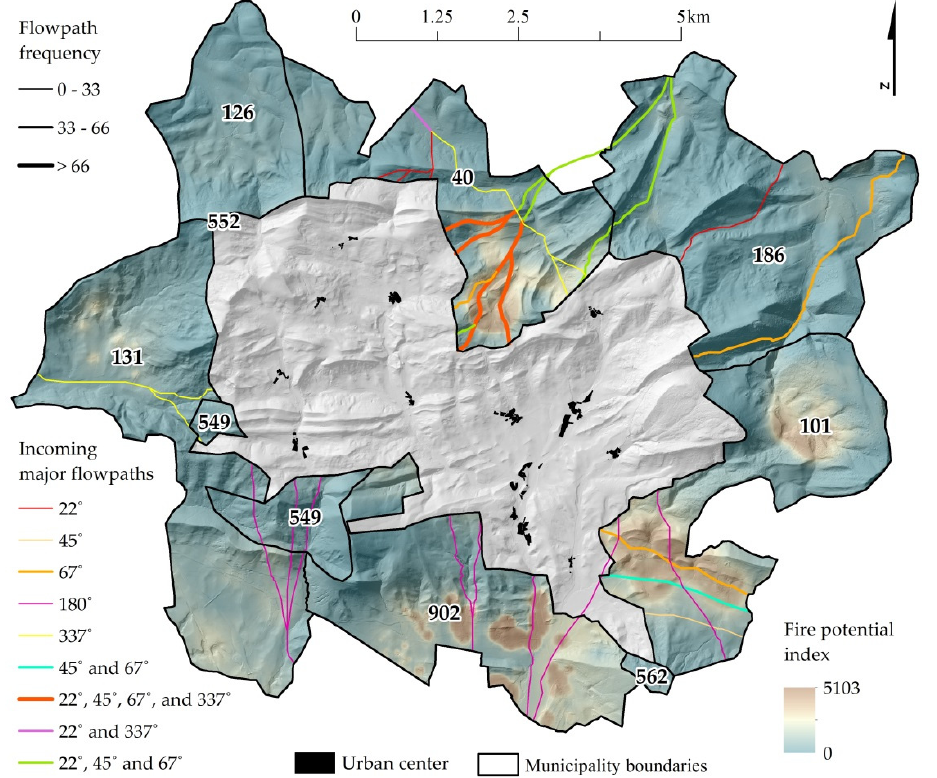
Figure 5. Fire potential index (FPI) and incoming major flow-paths from the surrounding municipalities. FPI was calculated by combining the fire size and ignition probability output grids, and was used to identify the areas where the ignition of a large fire is more likely [31]. Major flow-paths were obtained with the minimum travel time algorithm (MTT) [62] considering the five most recurrent fire weather scenarios (Table 2). The flow-path thickness indicates frequency and color indicates fire scenarios.